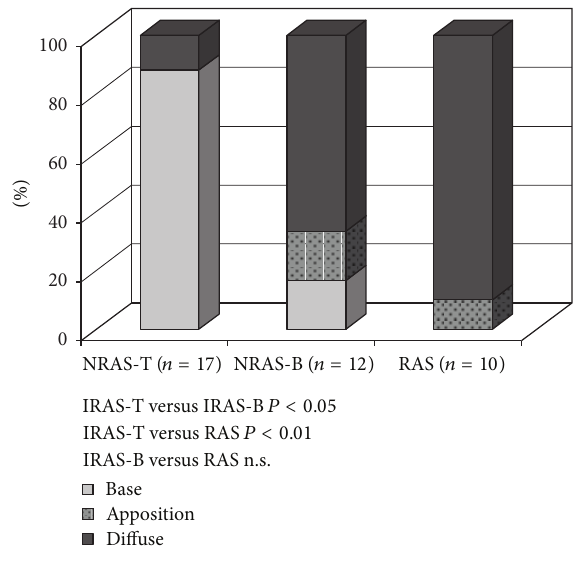
Figure 2: Localisation of calcification; number of valves given as percent (%) of ( 𝑛 ). RAS = rheumatic aortic stenosis, NRAS = non rheumatic aortic